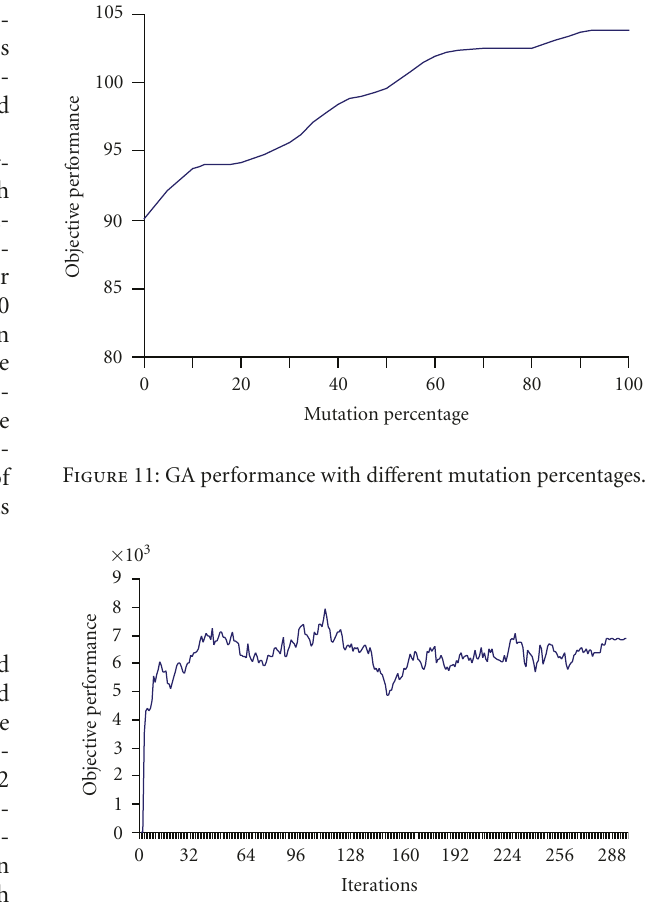
Figure 12: Objective function progress with number of